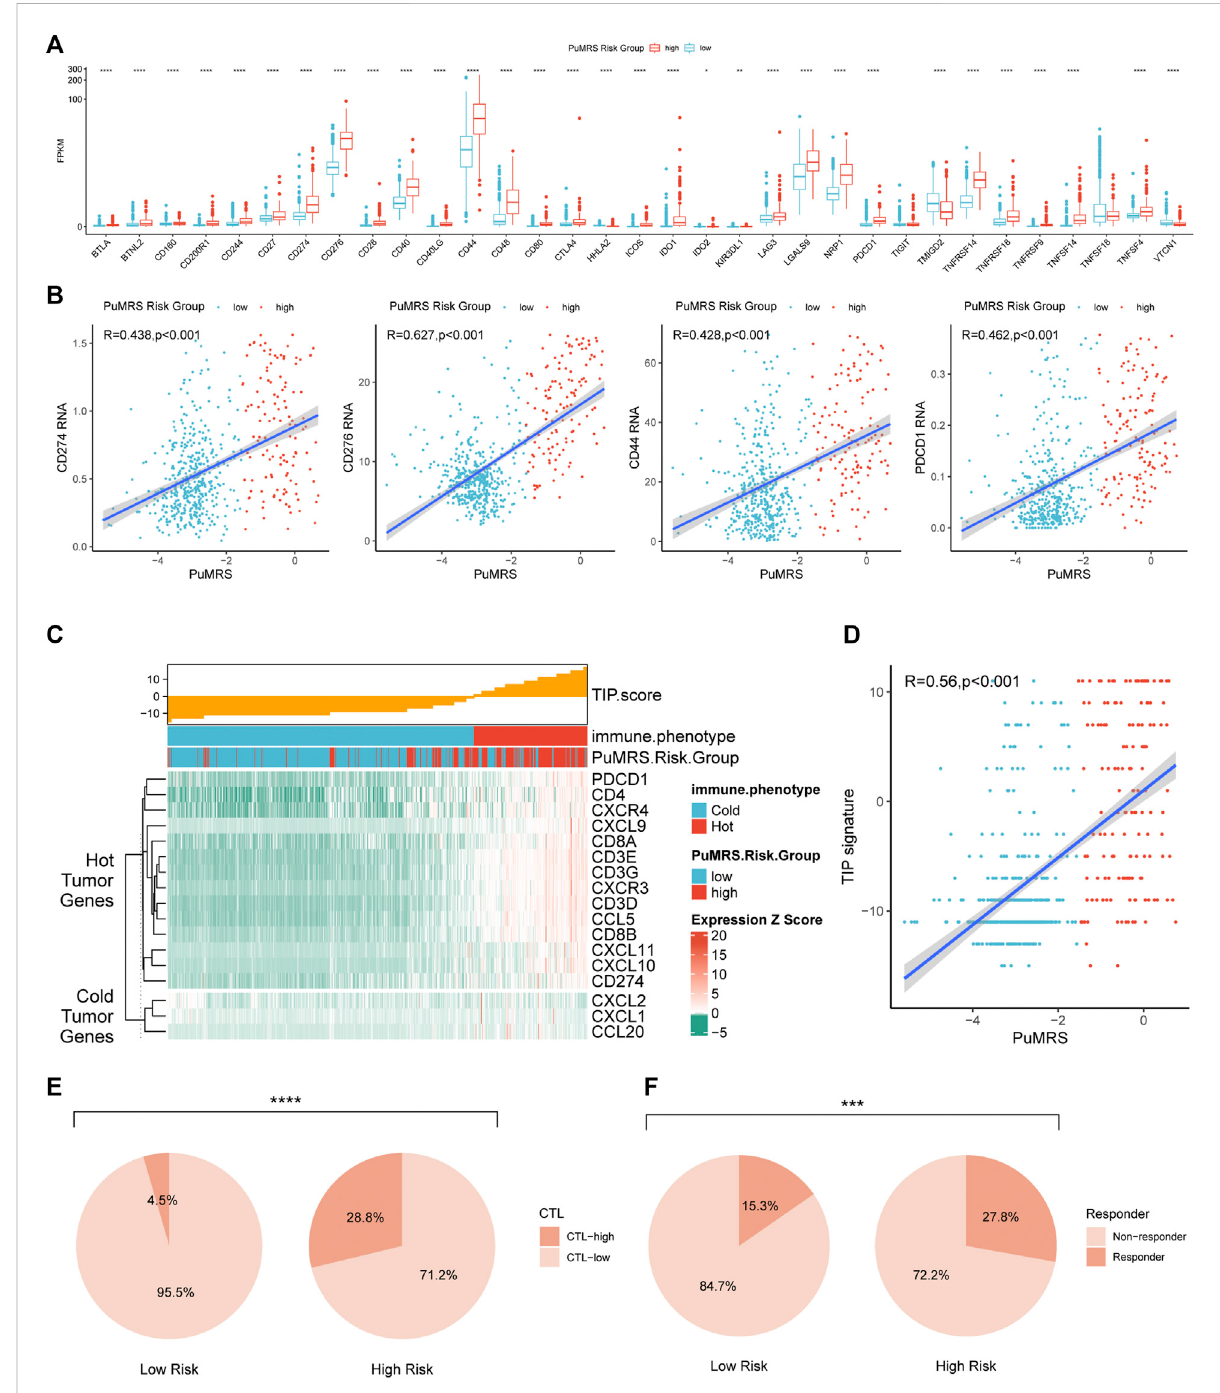
FIGURE 9 Differences in expression of immunotherapy targets and response to ICIs between two PuMRS risk groups. (A) The expression level of 33immunotherapy-relatedgenesintworiskgroups. (B) AnalysesofcorrelationsofPuMRSwiththeexpressionofCD274,CD276,CD44,andPDCD1. (C) TIPscoresandrelatedgeneexpressionlevelsbetweentworiskgroupsinTCGAdatasets. (D) AnalysesofcorrelationsofPuMRSwiththeTIPscore. (E) Percentage of predicted CTL level in each risk group. (F) Percentage of predicted responders to immune checkpoint inhibitors therapy in each risk